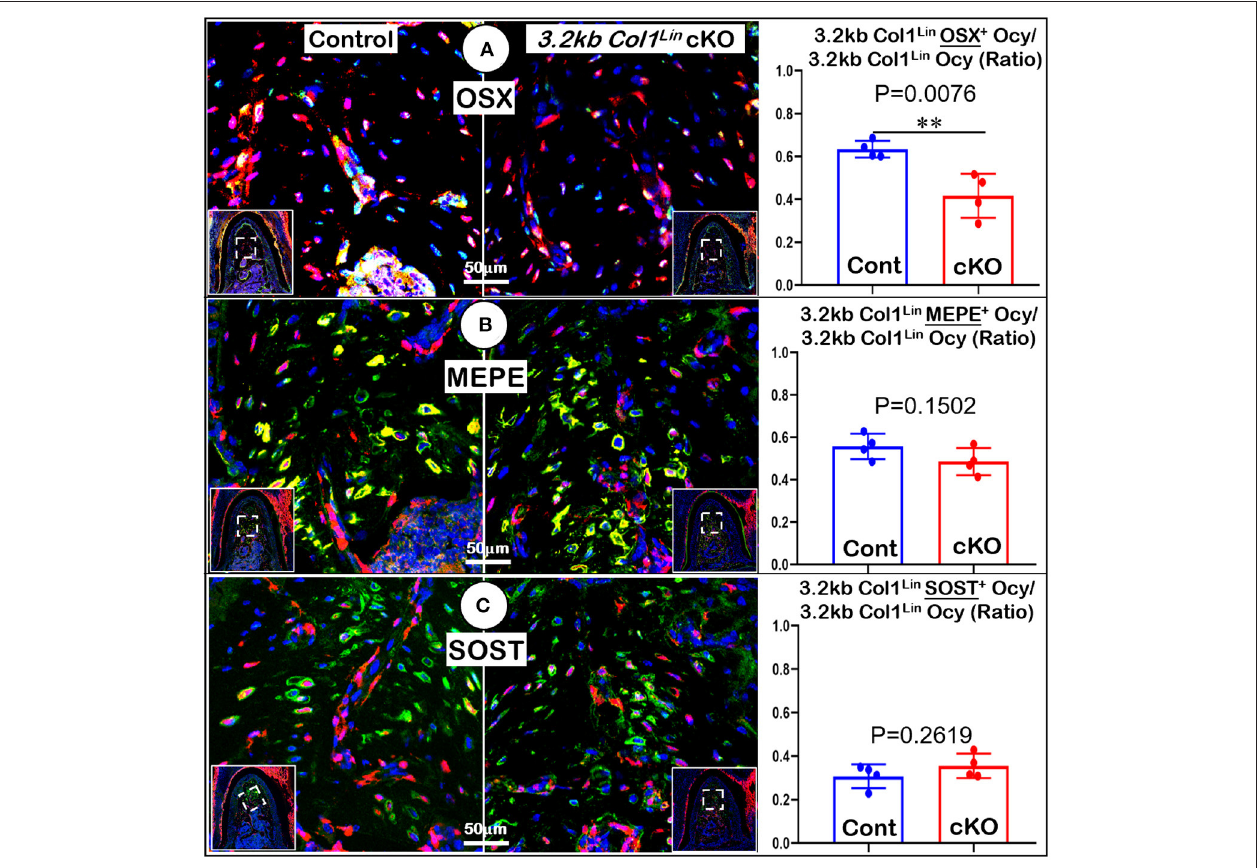
FIGURE 6 | Molecular analyses of mandibles from 3.2kb Col1 Lin Tgf β r2 conditional knockout (cKO) mice. (A) The confocal images of OSX immunostainings revealed a decrease in the raito of OSX + -3.2kb Col1 Lin Ocy to the total 3.2kb Col1 Lin Ocy in cKO alveolar bone, which was statistically significant from the control ( right panel